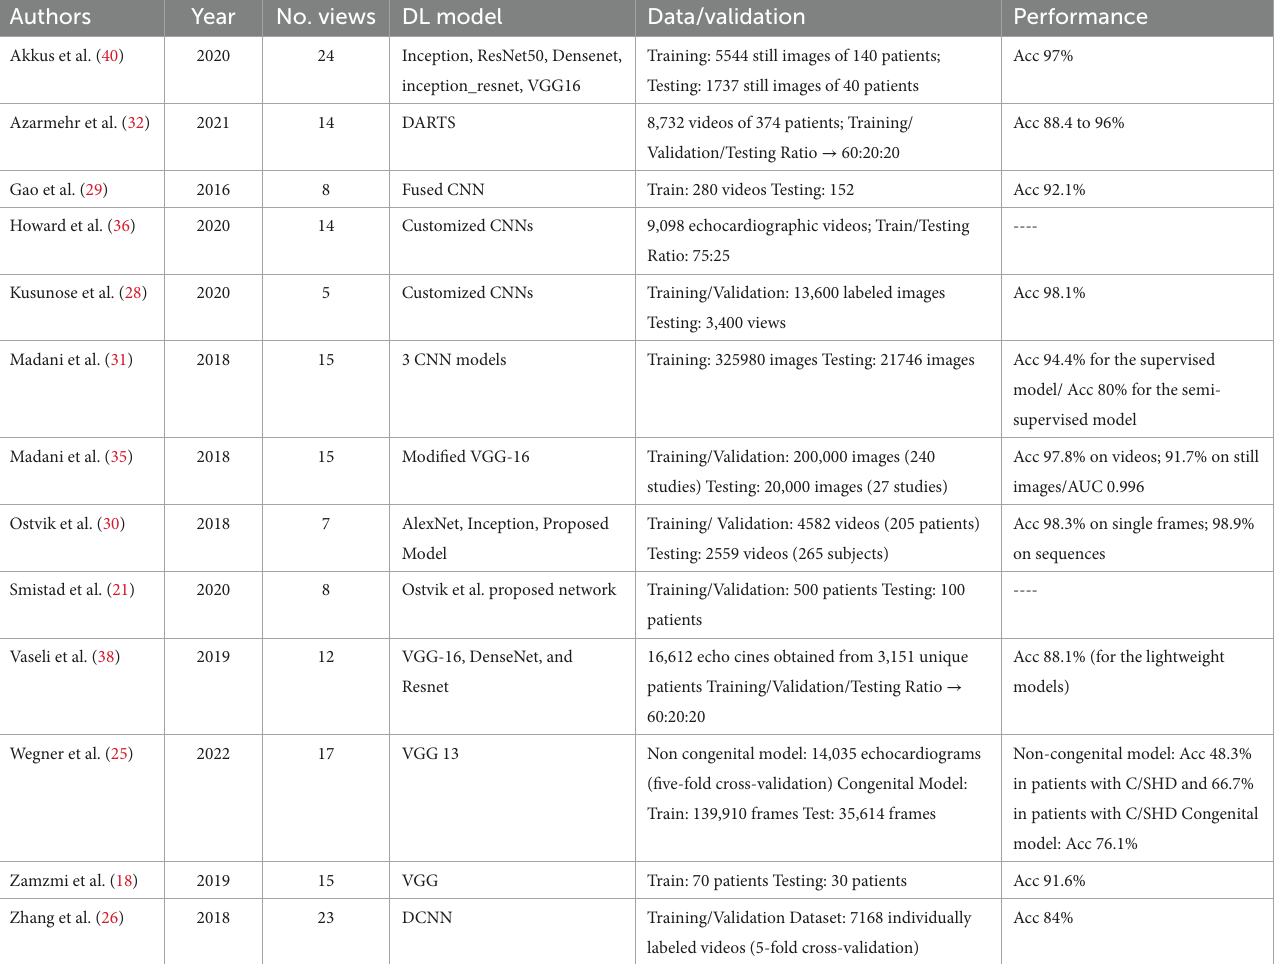
TABLE 2 Deep learning based studies for cardiac view